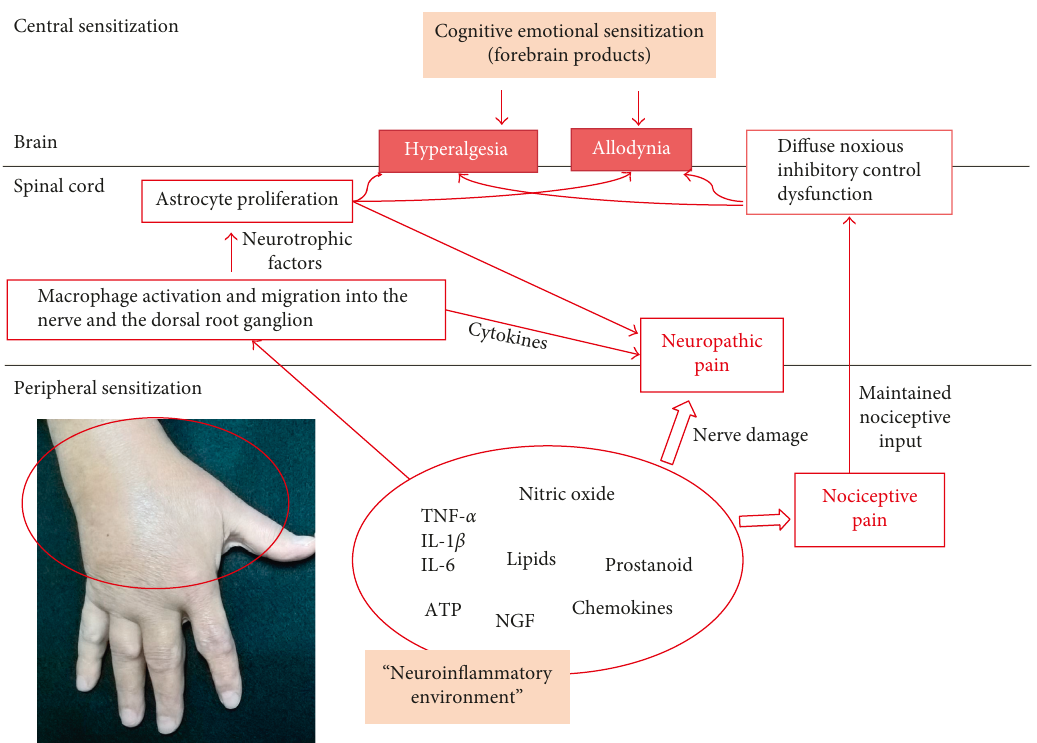
Figure 1: Peripheral and central mechanisms of pain sensitization in inflammatory arthritis. Synovitis can induce the production of molecules responsible for both nociception and neuropathic pain (through the damage of the nerves and the recruitment of macrophages in the nerves themselves and in the dorsal root ganglion). Repeated nociceptive stimuli can modify the function of the diffuse noxious inhibitory control (DNIC), with augmented pain perception as a consequence. Inflammatory cells stimulate, at the level of the central nervous system, the glial cell proliferation. Glial cells in turn provoke neural alterations responsible, at least in part, for hyperalgesia and allodynia. Pain sensitization is also strongly influenced by the psychological